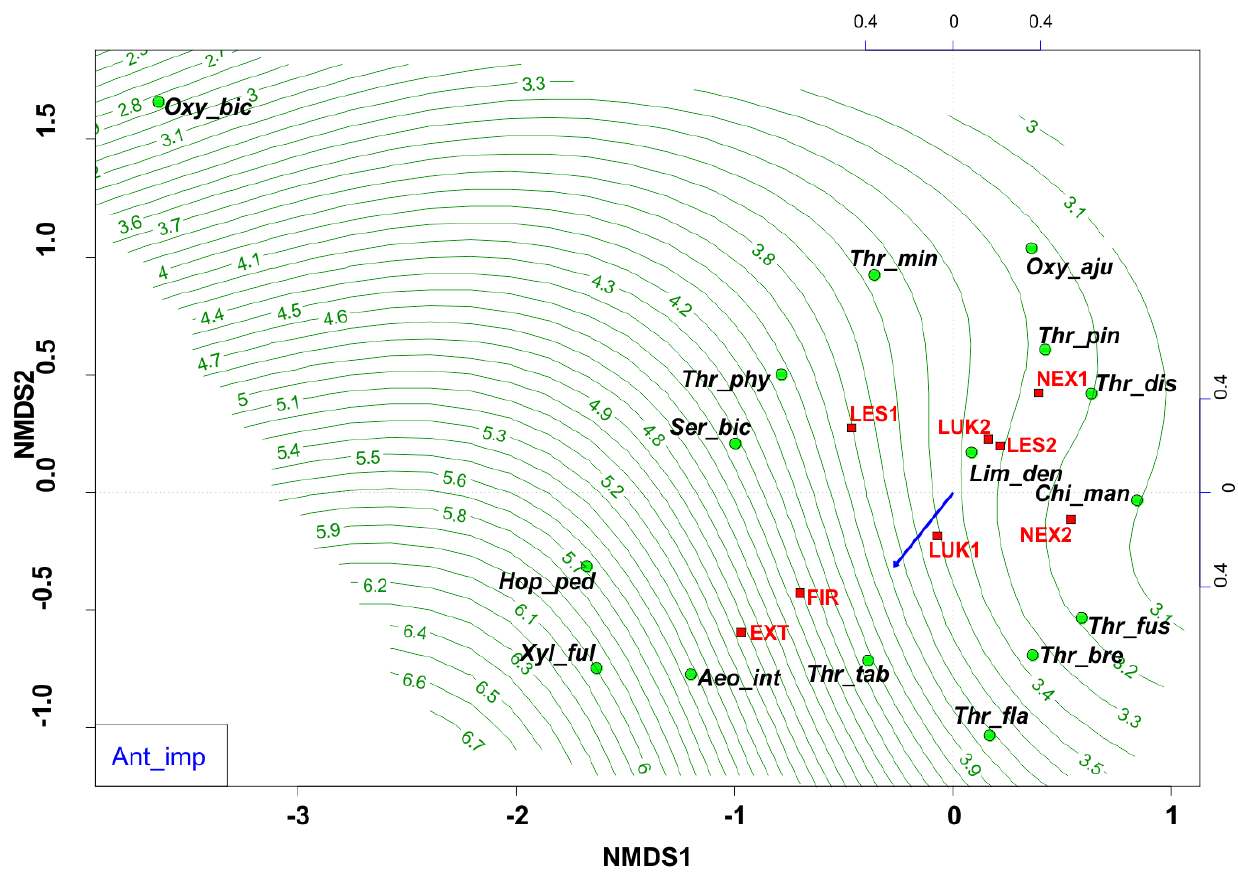
Figure 8. Nonmetric multidimensional scaling (NMDS) plot showing the relatedness of the thrips assemblages between the different samples and study plots (EXT, FIR, NEX1, NEX2, LUK1, LUK2, LES1, LES2) and the impact of anthropogenic impact (blue arrow, green contour line).